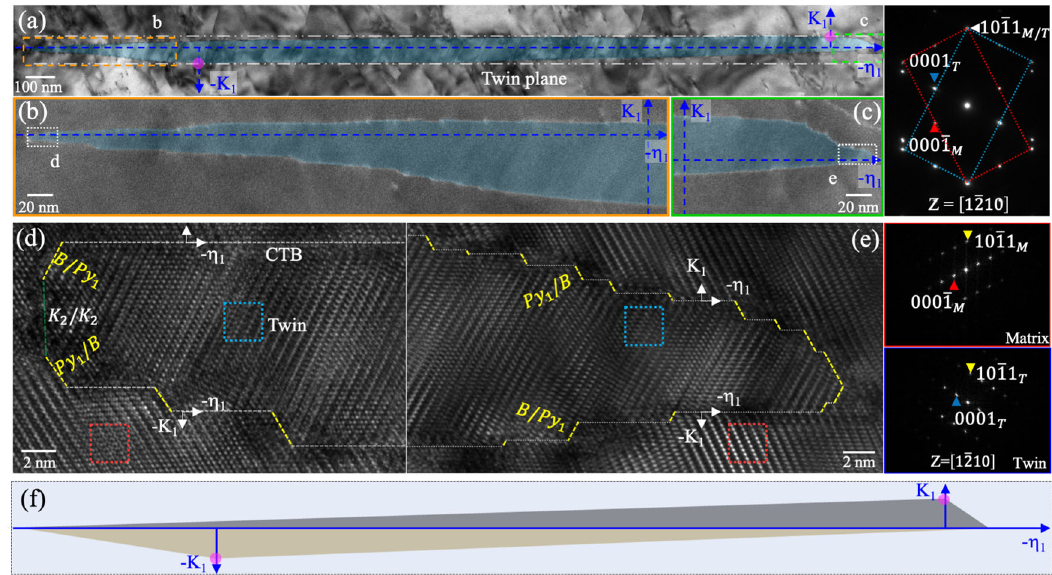
(cid:4) (cid:5) (cid:6) twin in 1210